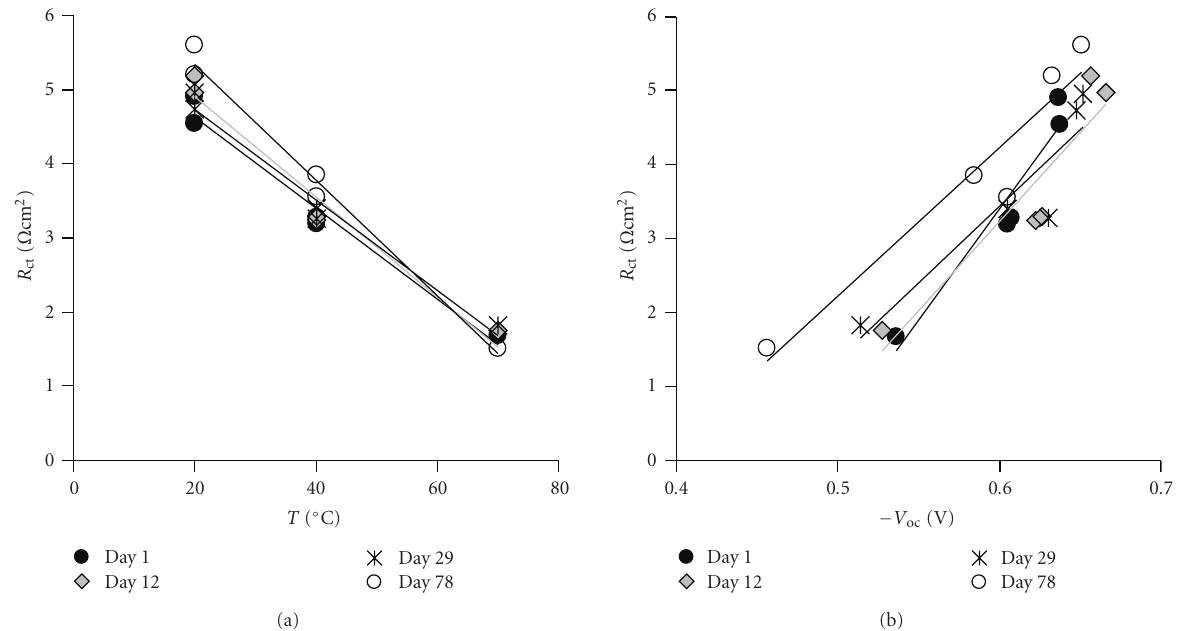
Figure 14: Charge transfer resistance on the counter electrode as a function of temperature (a) and open circuit voltage (b). First set of EIS measurements.